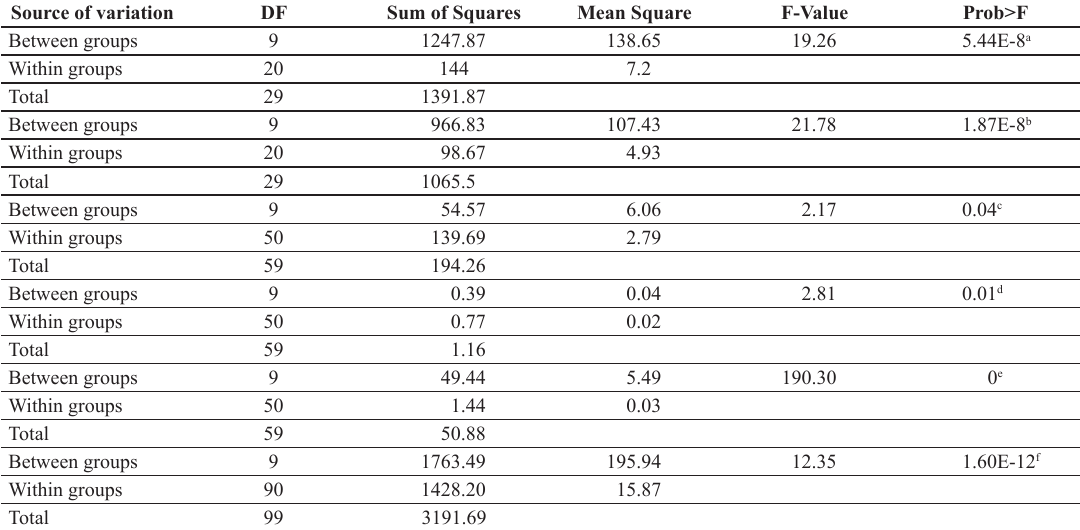
Table 5. One-way ANOVA on thermal comfort properties of the P/C blend fabric. Source of